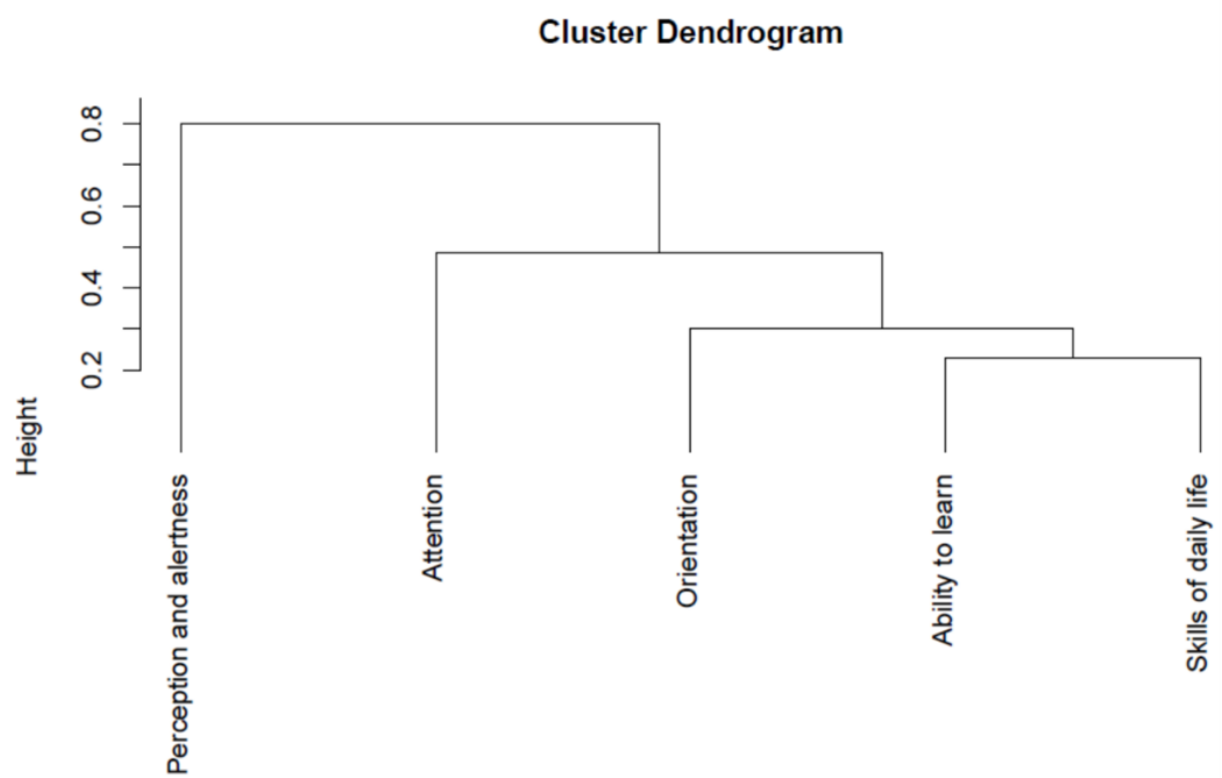
Figure 2. Dendrogram of cognitive status